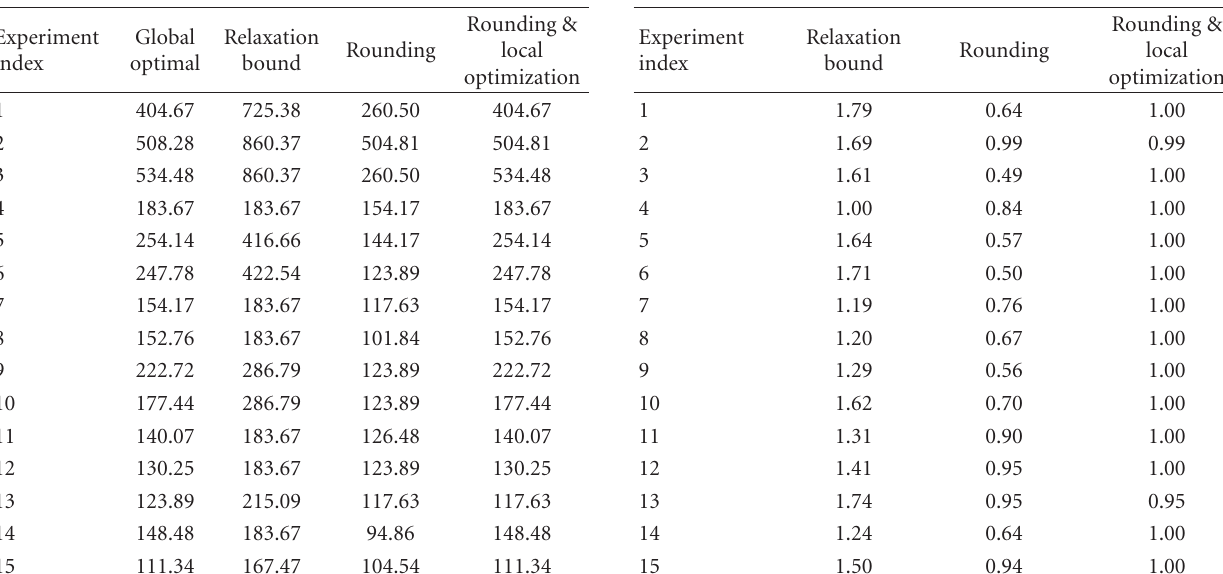
Table 4: Throughput comparison for random topology. Table 5: Optimality ratio comparison for random topology.